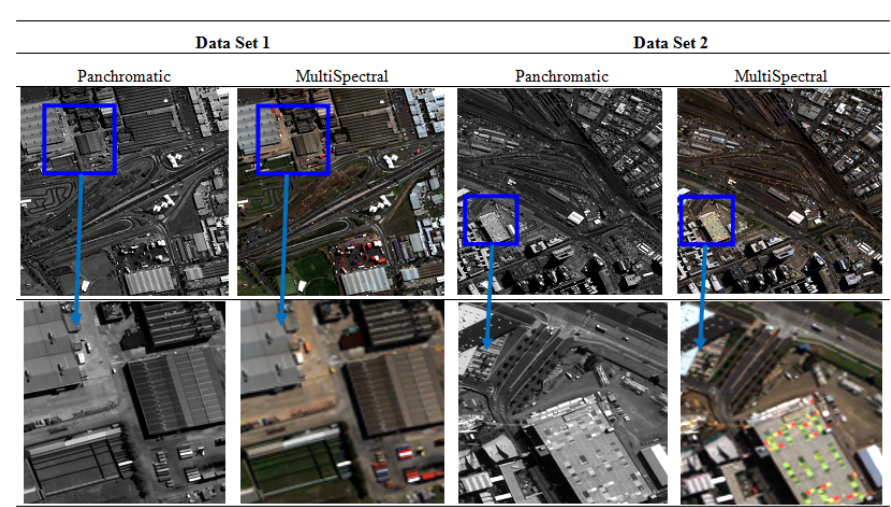
Figure 3. WorldView-2 data set.